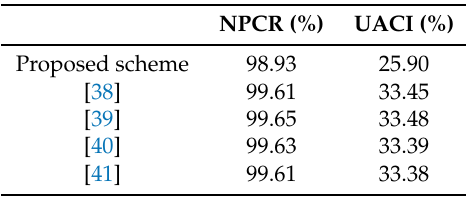
Table 4. NPCR and UACI for existing